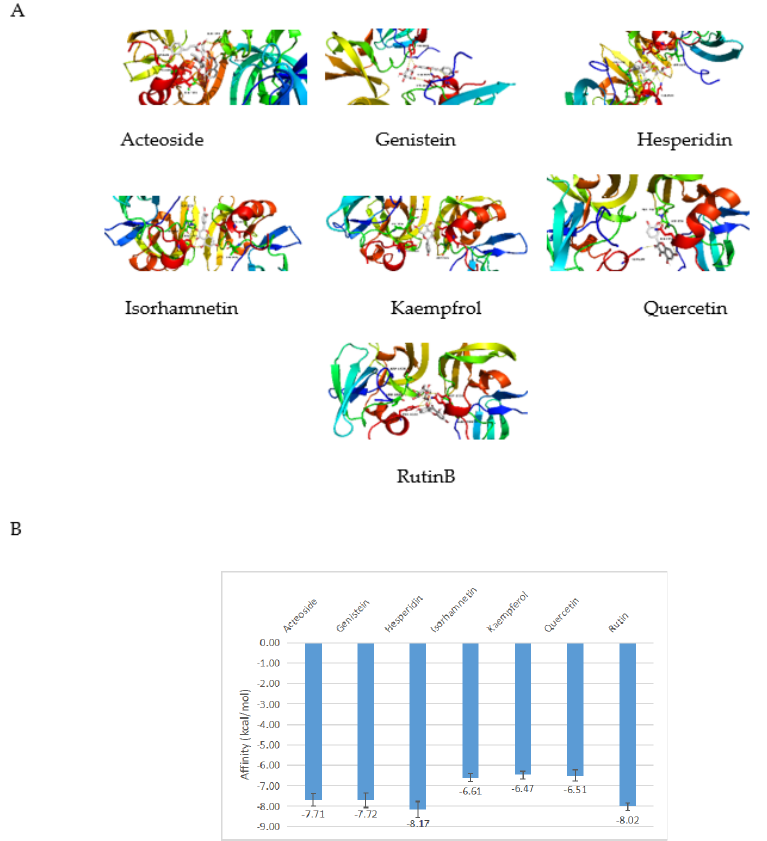
Figure 6. Molecular docking models of osmanthus fragrans extract and TP53: ( A ) 7 main components of osmanthus fragrans extract were docked with TP53; ( B ) the affinity of each component with TP53.